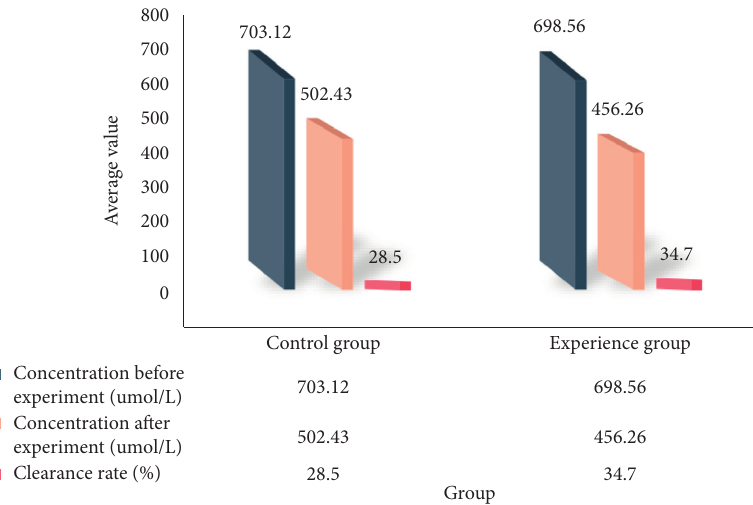
Figure 1: Analysis of SCR clearance effect in two groups.